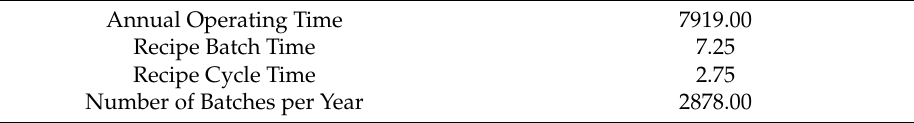
Table 7. The overall factory process